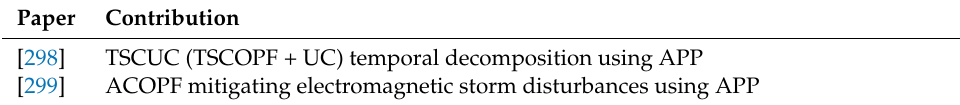
Figure 12. The occurrences of parallel classical power system studies. Table 9. Unique Formulations and Other SIMD-based state-of-the-art